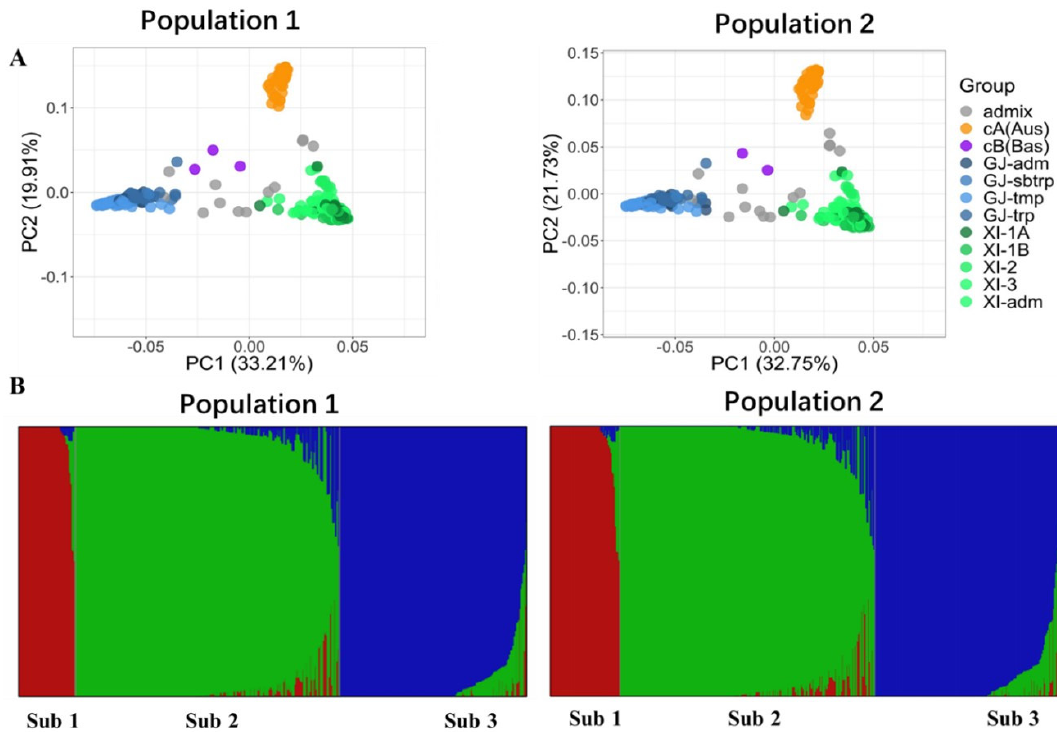
Figure 1. Structures of the two populations. ( A ) Population structure revealed by the plot of first two principal components. XI, indica; GJ, japonica; Aus, aus; Bas, basmati; and admix, admixed type. ( B ) Population structure is estimated by the program fastSTRUCTURE. The different colors represent subpopulations. Each vertical segment represents an accession, of which the colors indicate the degree of membership of the accession in different subpopulations.